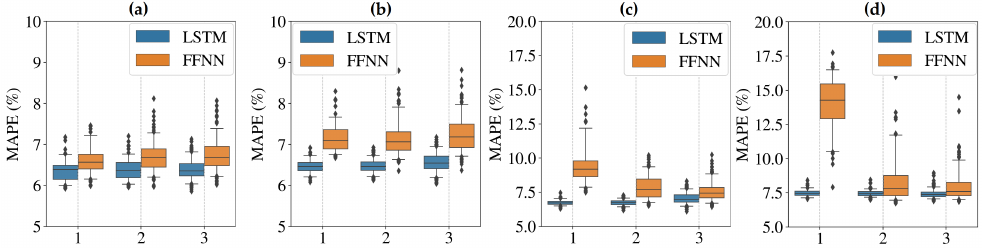
Figure 5. MAPE of the 20 simulation for each combination of nodes and layers grouped by the number of layers. In panel ( a – d ) are reported the results for the horizon of 1, 6, 24 and 168 h,